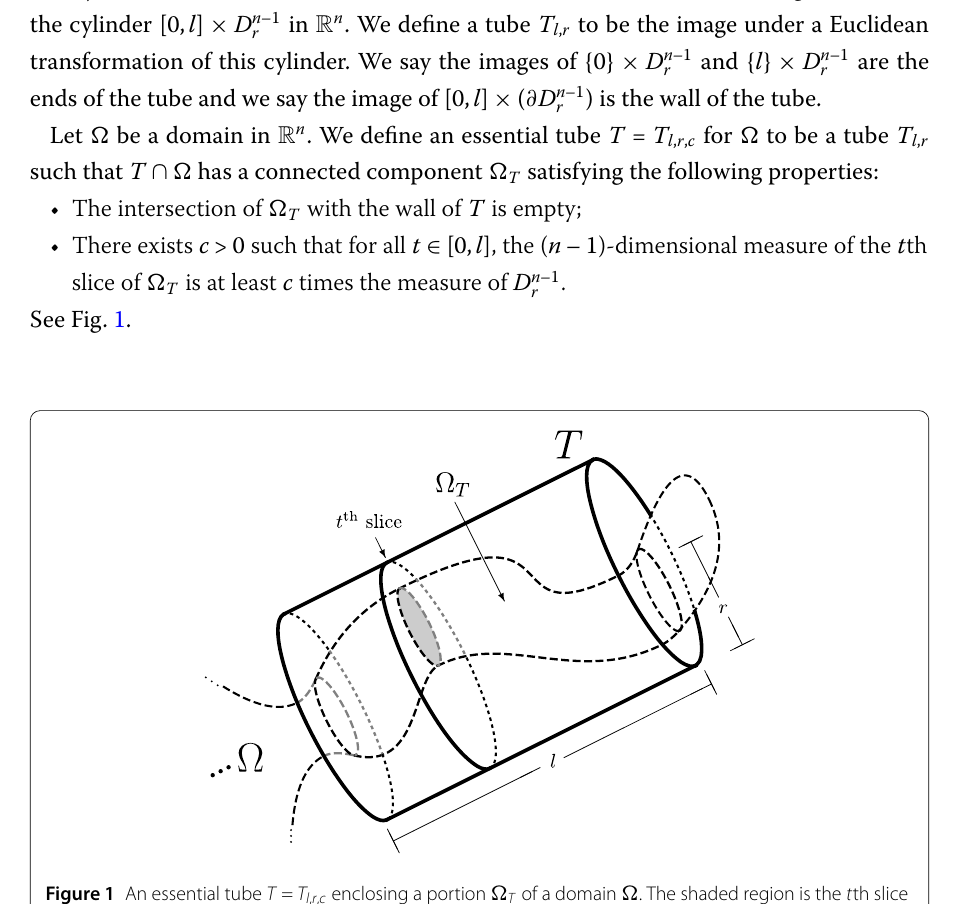
Figure 1 An essential tube T = T l , r , c enclosing a portion (cid:2) T of a domain (cid:2) . The shaded region is the t th slice of (cid:2) T and its ( n – 1)-dimensional measure is at least c times the measure of the corresponding slice of T , which in turn is isometric to D n –1